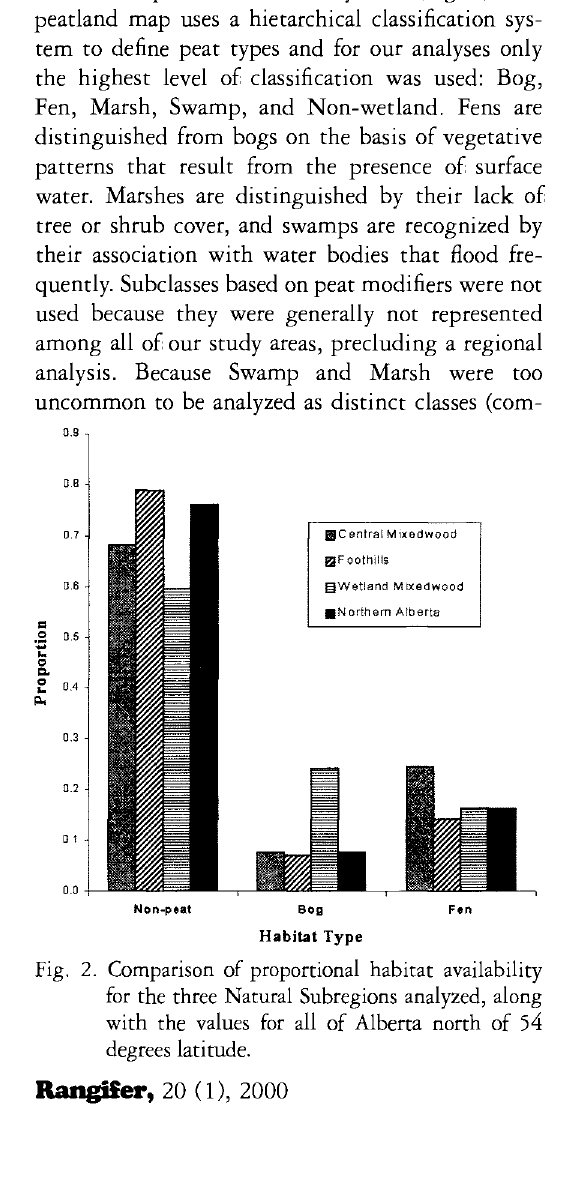
Fig. 2. Comparison of proportional habitat availability for the three Natural Subregions analyzed, along with the values for all of Alberta north of 54 degrees